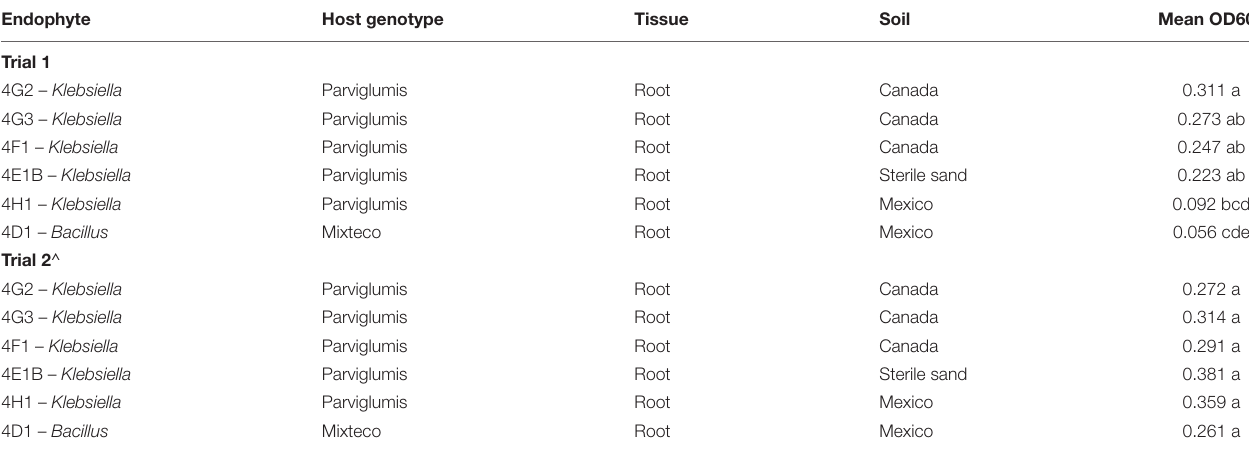
TABLE 1 | Summary of endophytes* that grew robustly in N-free growth trials in vitro .